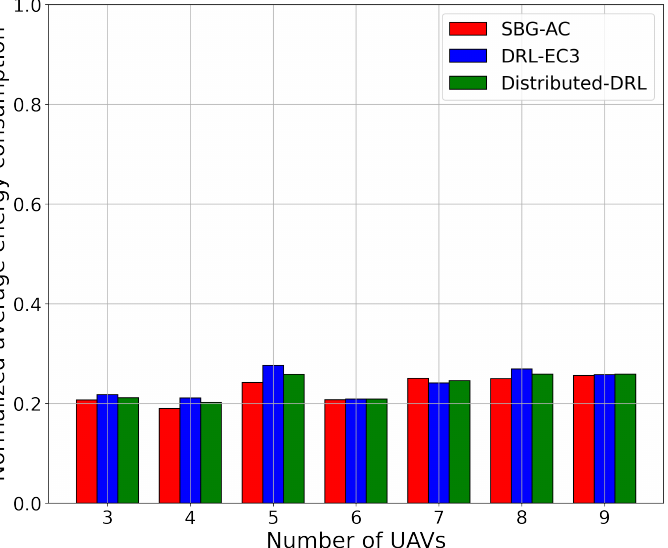
Figure 5. Normalized average energy consumption for a 3-, 4-, 5-, 6-, 7-, 8-, and 9-UAV